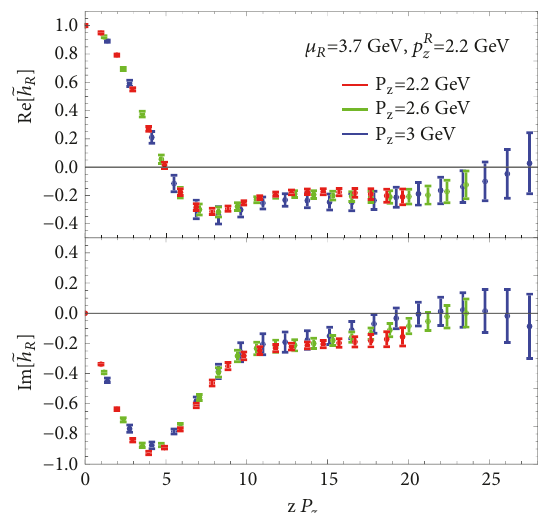
Figure 26: The real (top panel) and imaginary (bottom panel) parts of the matrix elements extracted from a two-state fit at momentum 3 GeV. The data are renormalized in the RI scheme and normalized with the matrix element of the local operator at same